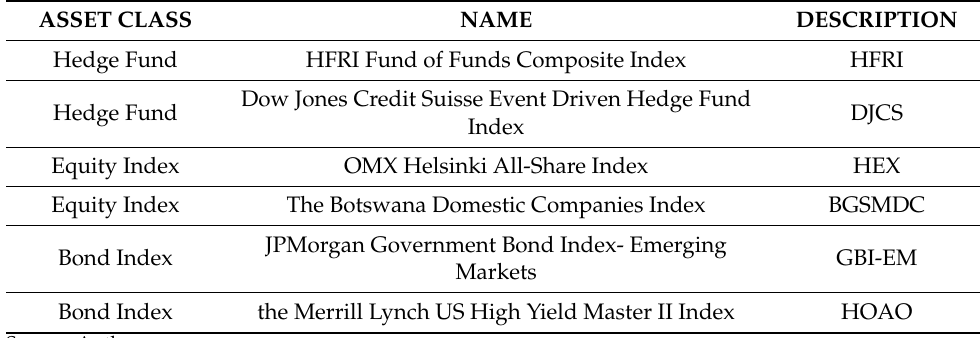
Table 1. Summary of asset classes representatives.